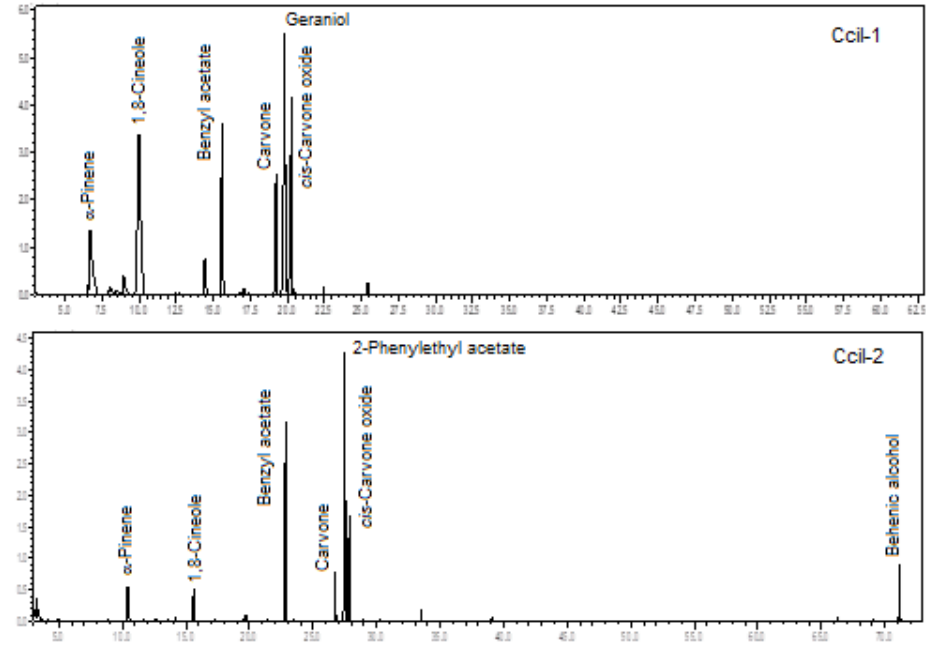
Figure 8. Ion-chromatogram of the Catasetum ciliatum volatile concentrates.